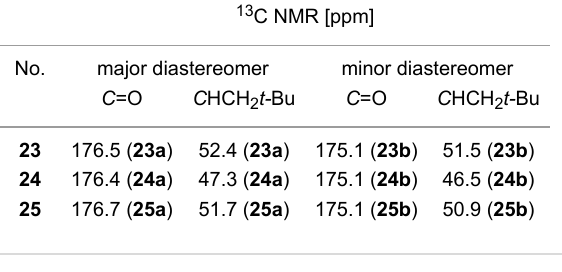
Table 1: 13 C NMR data of compounds 23 , 24 and 25